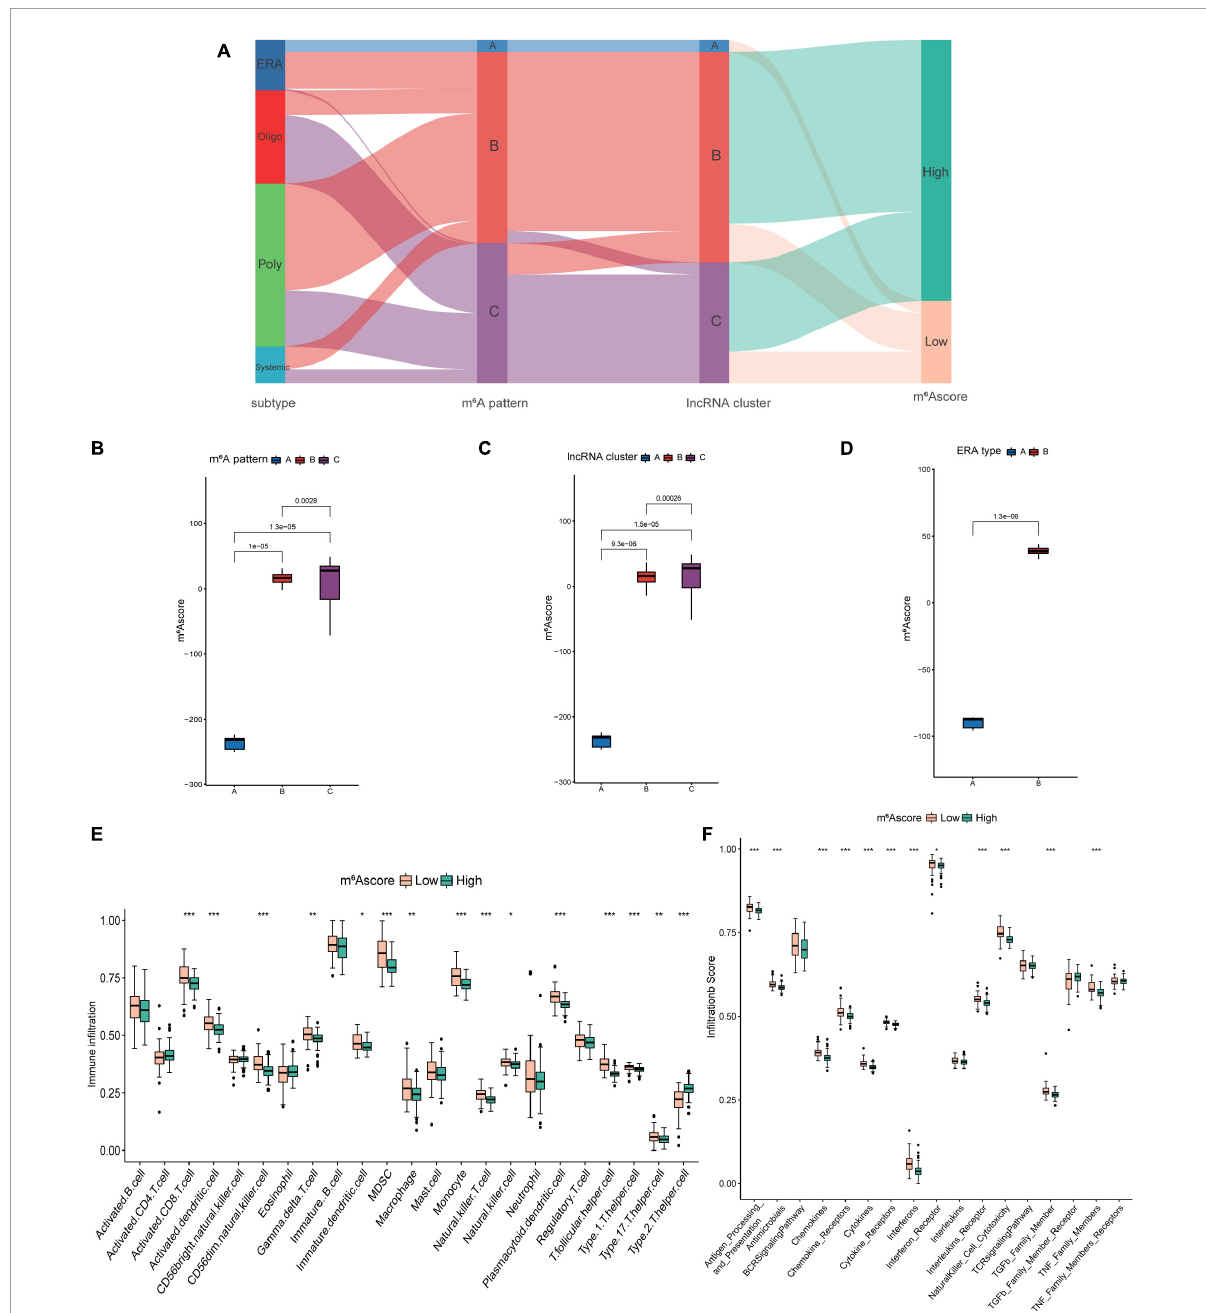
FIGURE10 The construction and application of m 6 Ascore. (A) Alluvial diagram showing the changes of juvenile idiopathic arthritis (JIA) subtypes, m 6 A patterns, long non-coding ribonucleic acids (lncRNA) clusters, and m 6 Ascore. (B) Differences in m 6 Ascore between the three m 6 A patterns. (C) Differences in m 6 Ascore between the three lncRNA clusters. (D) Differences in m 6 Ascore between the two subclusters of enthesitis-related arthritis (ERA). (E) The discrepancies in the abundance of each infiltrating immunocyte between the high and low m 6 Ascore groups. (F) The high and low m 6 Ascore groups exhibit varying degrees of immunological